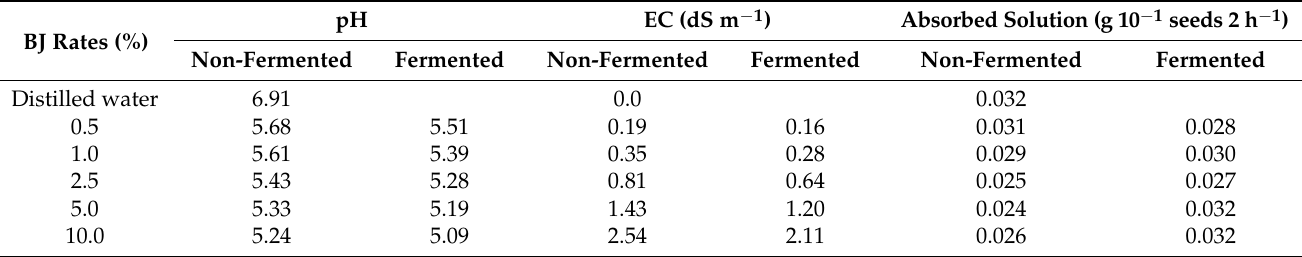
Table 2. pH and electrical conductivity (EC) values of fermented and non-fermented brown juice (BJ) solutions. pH EC (dS m − 1 ) Absorbed Solution (g 10 − 1 seeds 2 h − 1 ) BJ Rates (%)